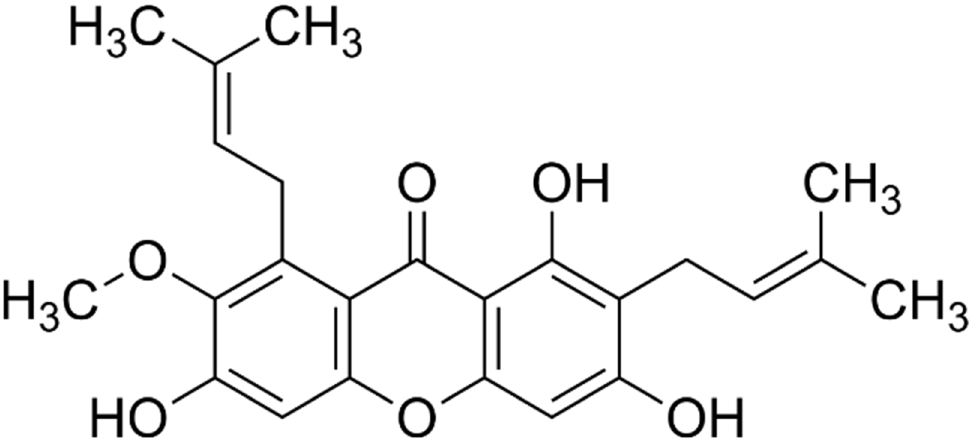
Figure 5. Chemical structure of α -mangostin.